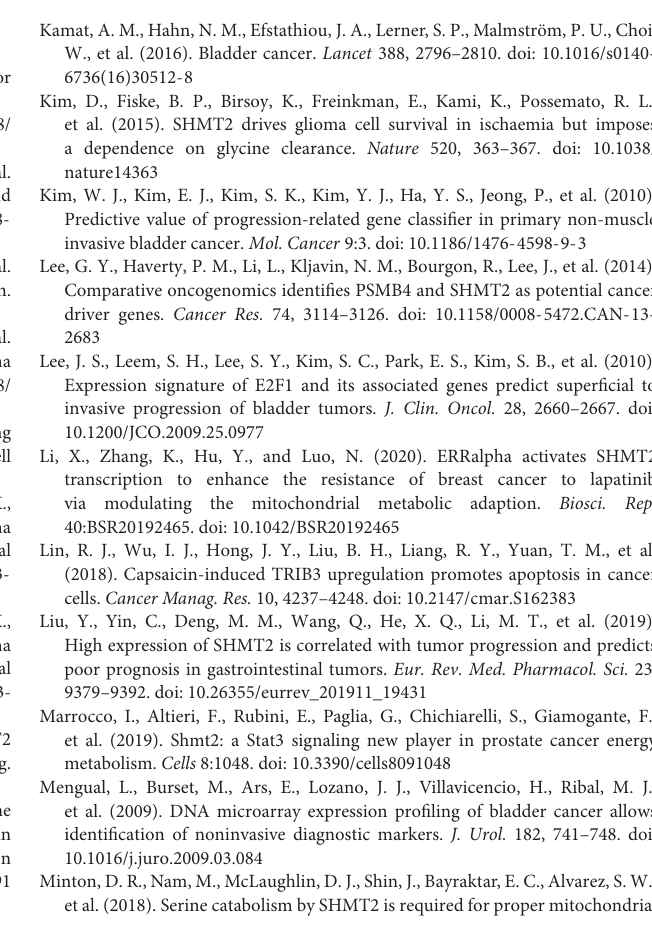
Supplementary Table 3 | KEGG pathway enrichment in BLAC with SHMT2 high